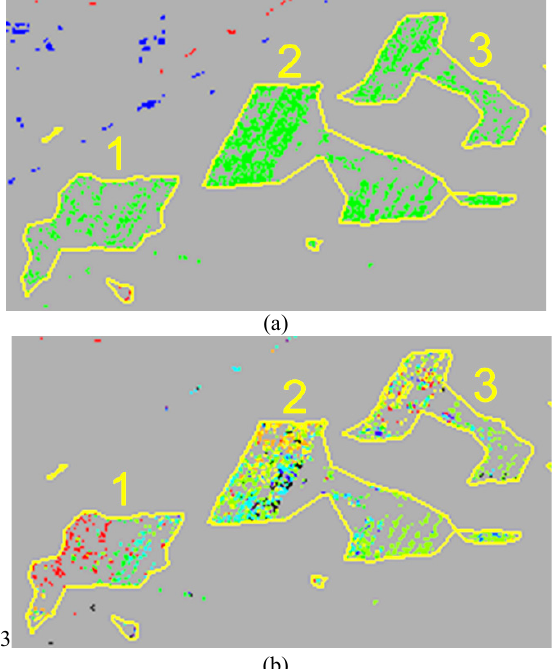
Figure 8. Spatiotemporal changes within area 1 in patch 1 (Figure 5). (a) EBC points are clustered as segments 1, 2, and 3 that correspond to three new office buildings of Federal Ministry of the Interior. (b) Mean and SD of emergence dates (unit: bd defined in Table 1). Segment 1: Mean, 25.1; SD, 3.1. Segment 2: Mean, 23.3; SD, 2.2. Segment 3: Mean, 23.9; SD,